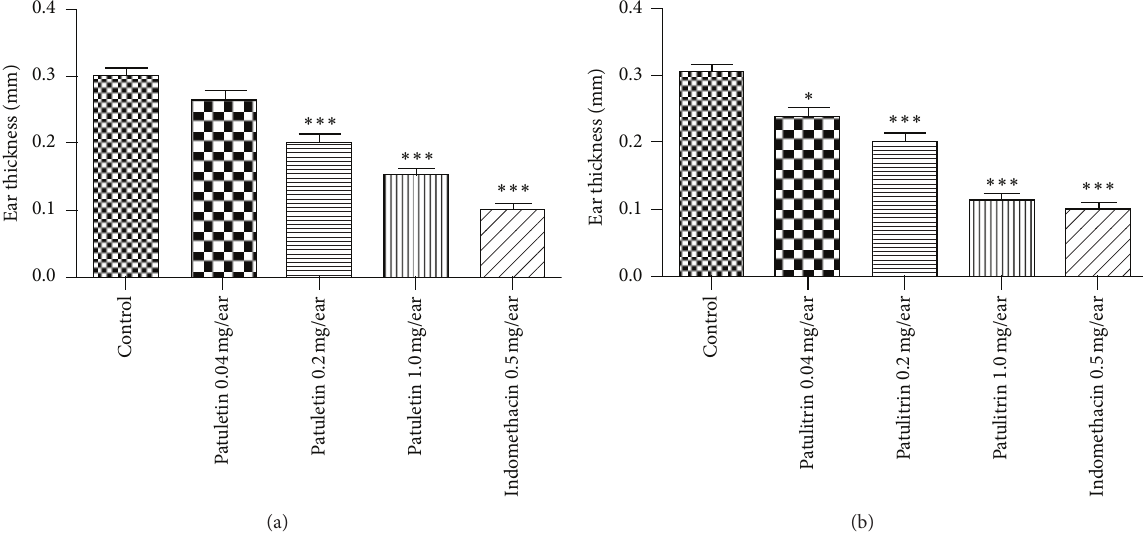
Figure 7: Inhibitory effect of patuletin and patulitrin on AA-induced ear edema in mice. Drugs were administered topically 30 min before AA (1mg). Significantly different from the control, ∗ 𝑃 < 0.05 , ∗∗ 𝑃 < 0.01 , or ∗∗∗ 𝑃 < 0.001 . Each value represents the mean ± SD of 4